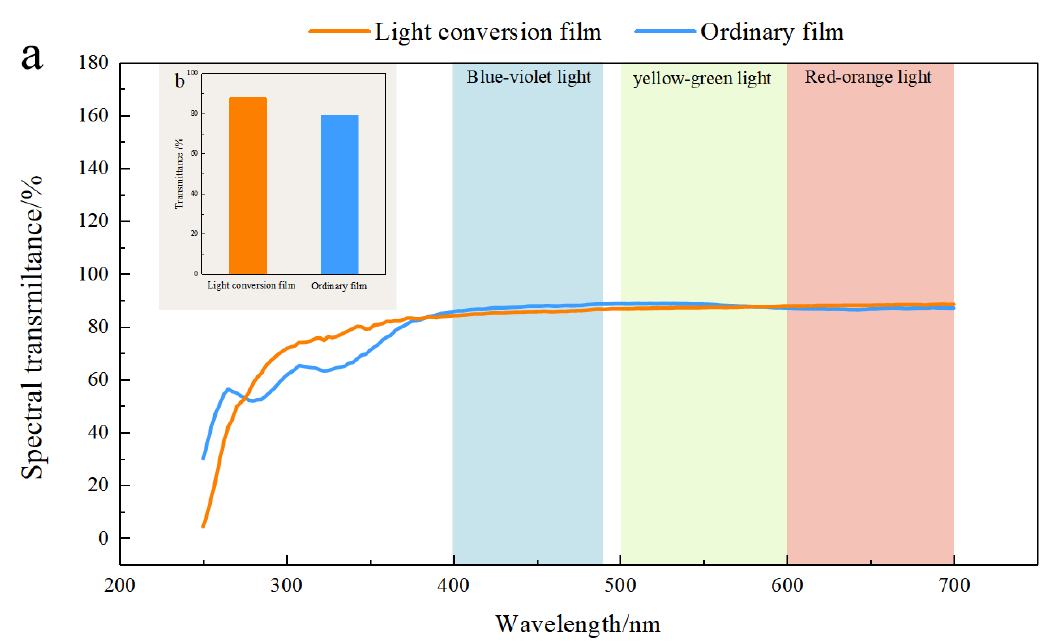
Figure 2. Performance test of light conversion film and ordinary film for spectral transmittance and transmittance ( a ) Indicates the performance analysis of the spectral transmittance under the light conversion film and ordinary film; ( b ) Indicates the performance analysis of light transmittance under light conversion film and ordinary film.